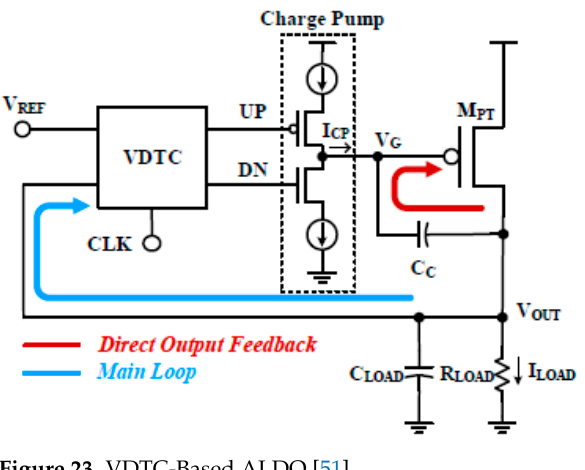
Figure 23. VDTC-Based ALDO